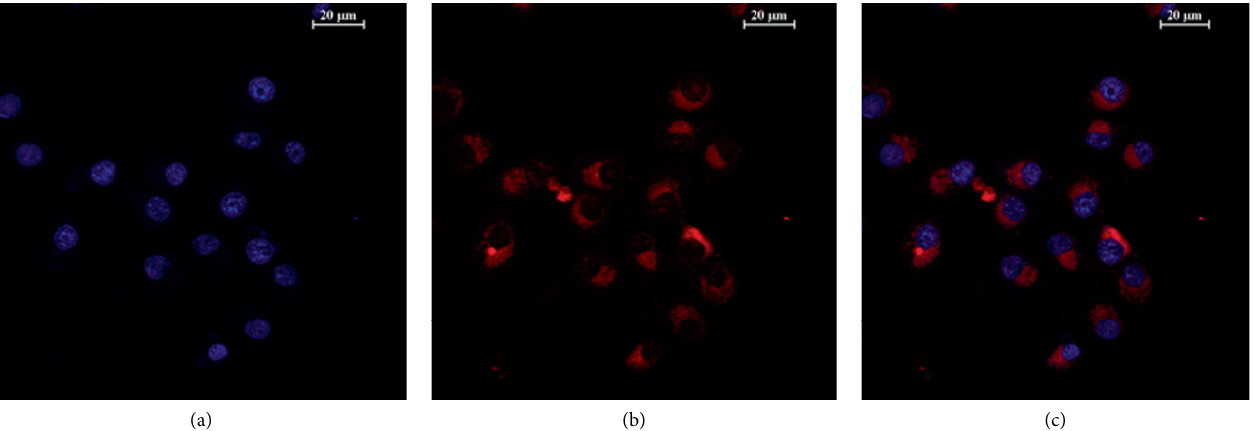
Figure 5: Confocal laser scanning microscope (CLSM) images of HeLa cells co-cultured with the prepared DOX-MCNs nanoparticles for 4 h. The left column (a) was Hoechst 33342 (blue) staining nucleus, the middle column (b) was DOX (red), and the right column (c) was a merged image from left column and middle column.